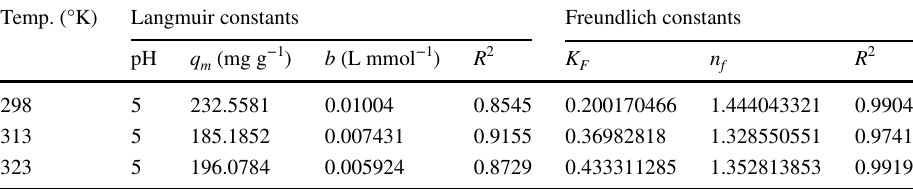
Freundlich isotherm model parameters for Cd(II) biosorption on N.